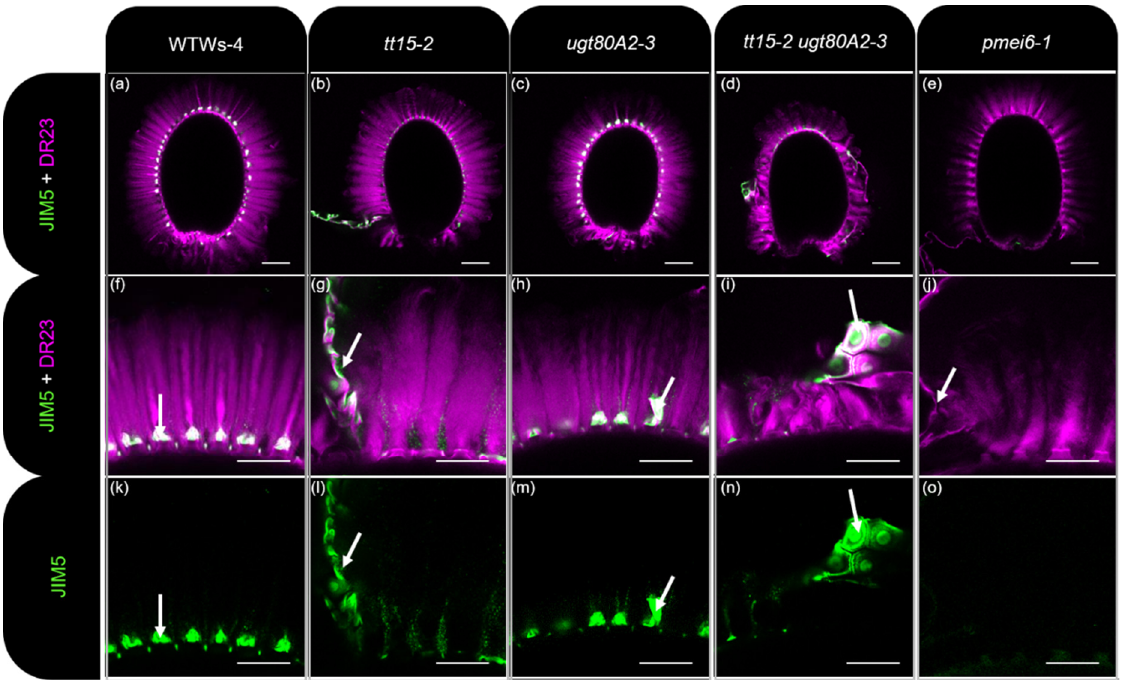
Figure 5. Methylesterified HG is present in outer cell wall fragments released from tt15 seed coat epidermal cells on imbibition. Confocal microscopy optical sections of seed coat epidermal cells and inner mucilage released from mature seeds after labeling of partially methylesterified HG epitopes with JIM5 antibodies (green) and staining cellulose with Direct Red 23 (DR23; magenta). ( a – j ) are composite images of double labeling, whereas ( k – o ) are JIM5 labeling alone. ( a – e ) show whole seeds, and ( f – o ) are higher magnifications of a zone from the same whole seed image above each, respectively. WT, wild type. Bars = 100 µm ( a – e ) and 50 µm ( f – o ). White arrows indicate outer cell wall fragments within mucilage. All genotypes are in the Ws-4 background, except pmei6-1 which is in Col-0. JIM5 labelling of outer cell wall fragments in wild type Col-0 [17] resembles that of Ws-4.